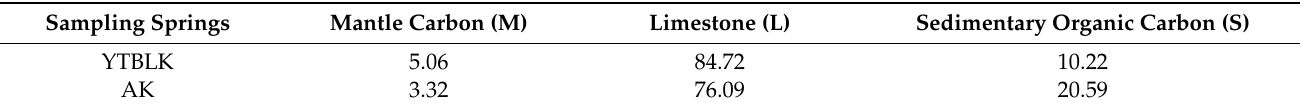
Table 4. The CO 2 gas from mantle, limestone, and sedimentary sources in the hot spring gases of the study